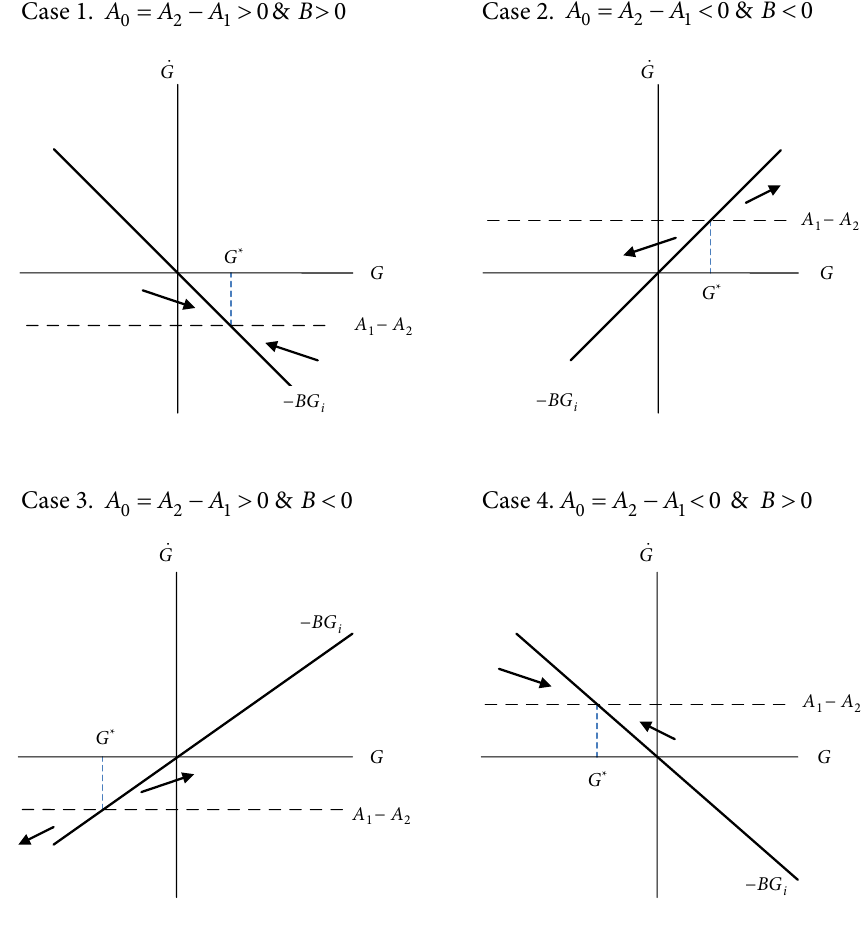
Fig. 4. Dynamics of the growth